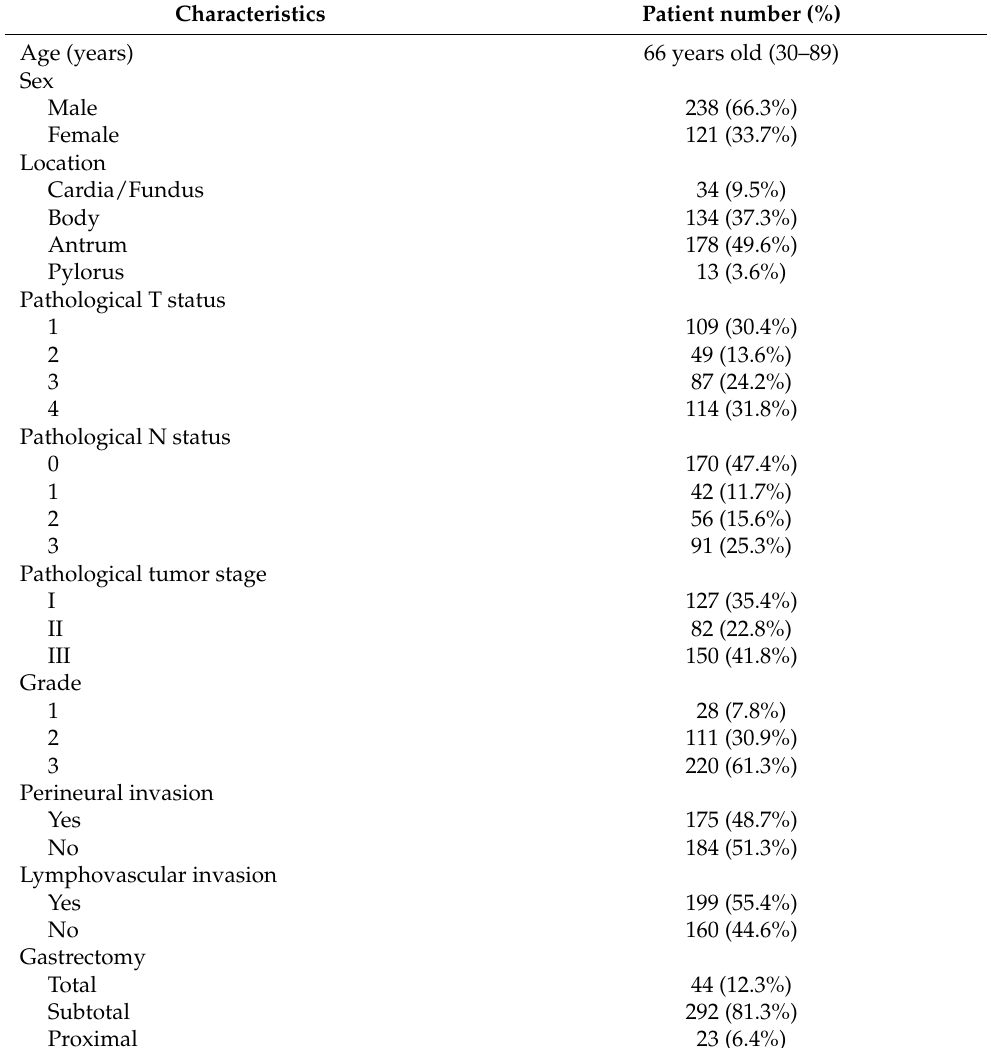
Table 1. Characteristics of 359 patients with gastric adenocarcinoma receiving surgical